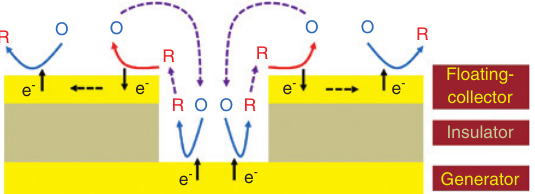
Figure 8: Schematic illustration of bipolar behavior occurring in the plane-recessed MEA configuration when recessed microdisk is set at reductive potential of oxidative species (initial species) while plane conducting film is left